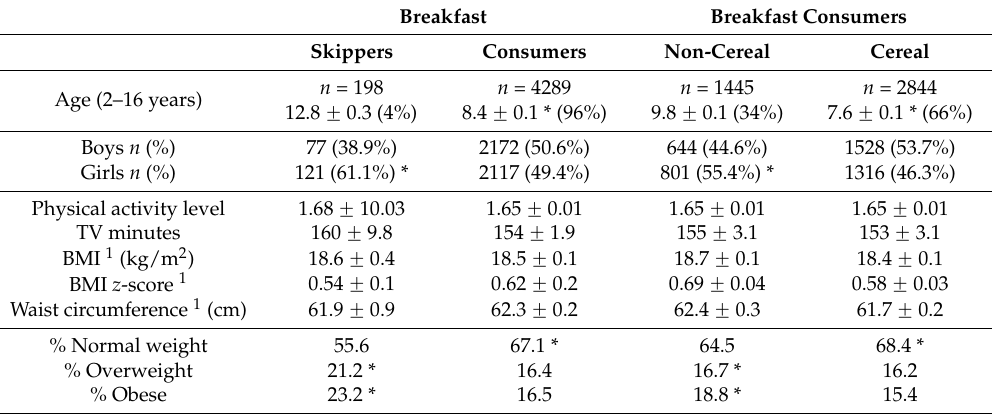
Table 2. Descriptive analysis of children and adolescents by breakfast categories (mean ˘ SE; % within each category).